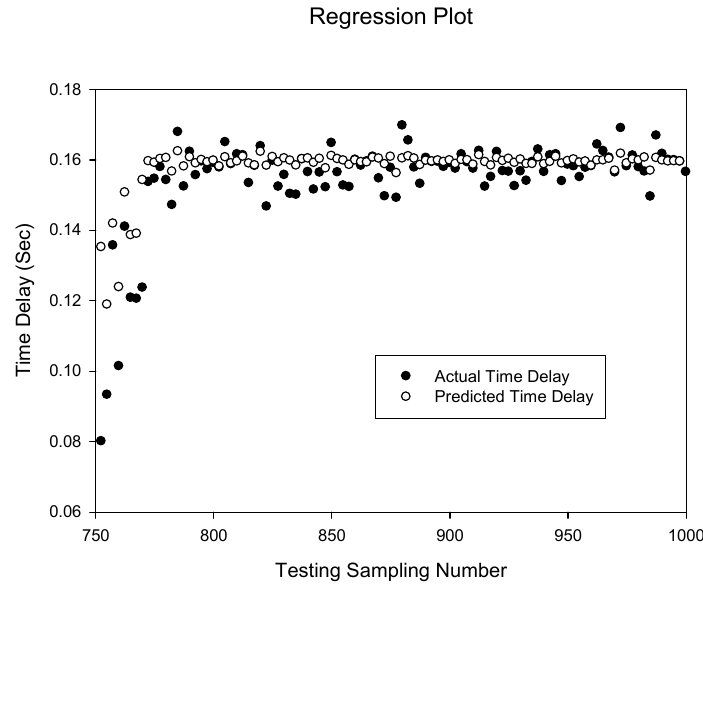
Figure 7. Prediction of delay sequence using NARXNN(d)